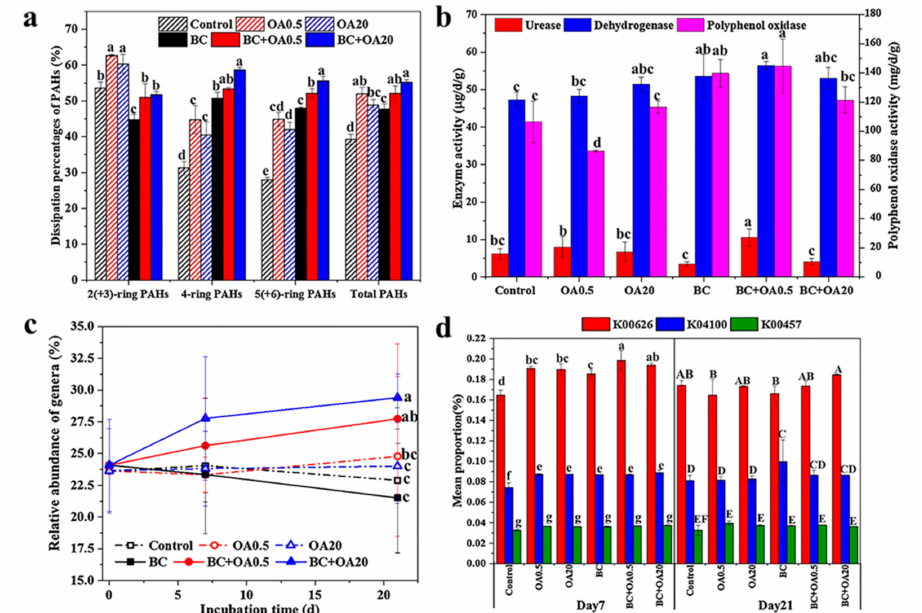
Figure 2. ( a ) Dissipation percentages of PAHs; ( b ) The regulation of urease, dehydrogenase, and polyphenol oxidase enzyme activity; ( c ) The genus-level community structure, after 21 days of incubation; and ( d ) Mean proportions of three functional genes associated with PAH degradation, BC: maize straw biochar, OA: oxalic acid. (Reproduced from ref. [38] with permission from Elsevier, copyright